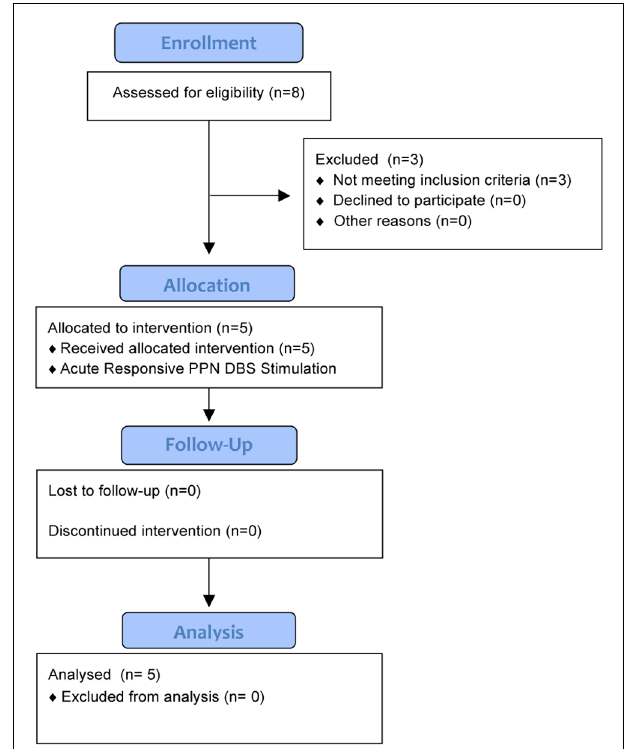
FIGURE 1 | The CONSORT diagram summarizes the study for 6 months of follow-up. Five subjects were enrolled into the study after screening eight potential candidates. Three candidates did not qualify as they did not exhibit five or more freezing of gait (FoG) episodes during the provocation protocol.